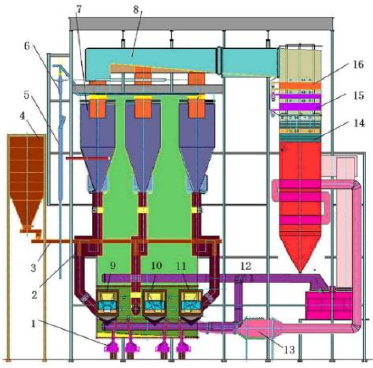
Figure 1. Schematic diagram of the 600 MW CFB boiler (1-slag cooler; 2-material returning device; 3-coal feeding route; 4-coal bunker; 5-storage tank; 6-steam separator; 7-cyclone separator; 8-flue duct; 9–11-external heat exchangers (EHEs); 12-secondary air duct; 13-ignition duct; 14-economizer; 15-low temperature reheater; 16-low temperature superheater).